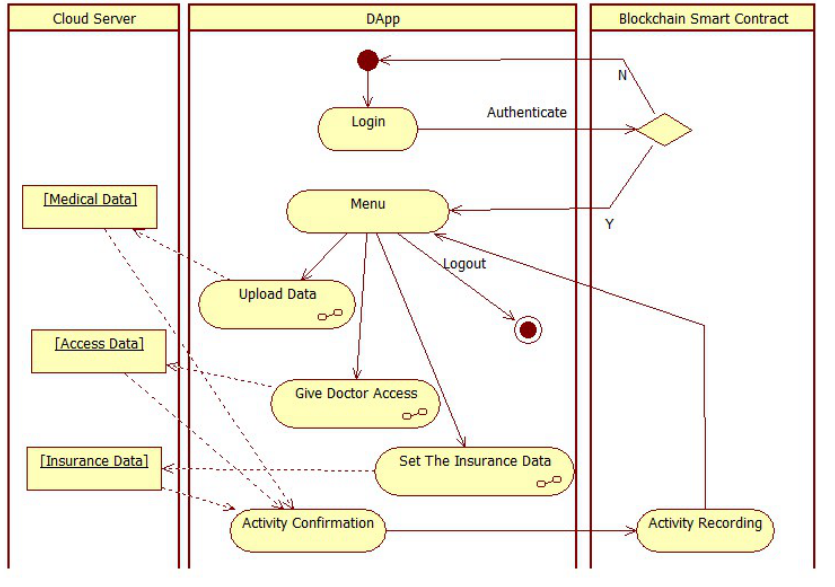
Figure 5. Activity diagram for the simple authentication